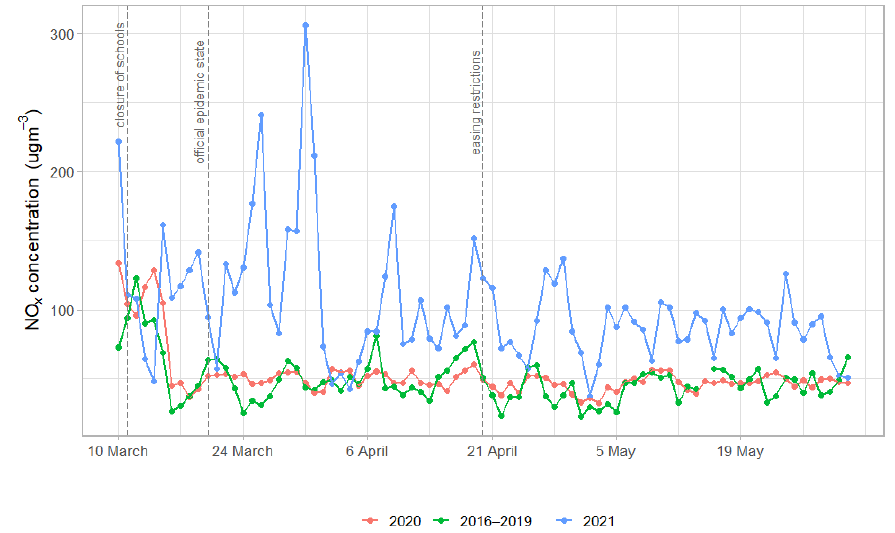
Figure 12. Average daily values of NO x concentrations in the period 10 March–31 May.